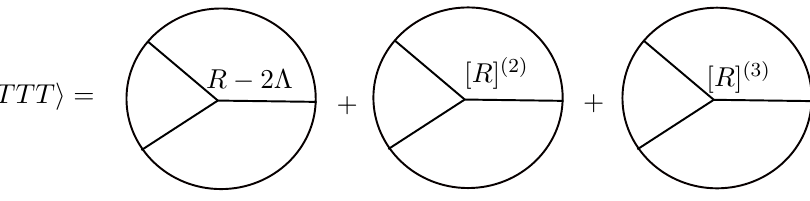
Figure 1 . Einstein, quadratic and cubic terms enumerate the stress-tensor three-point